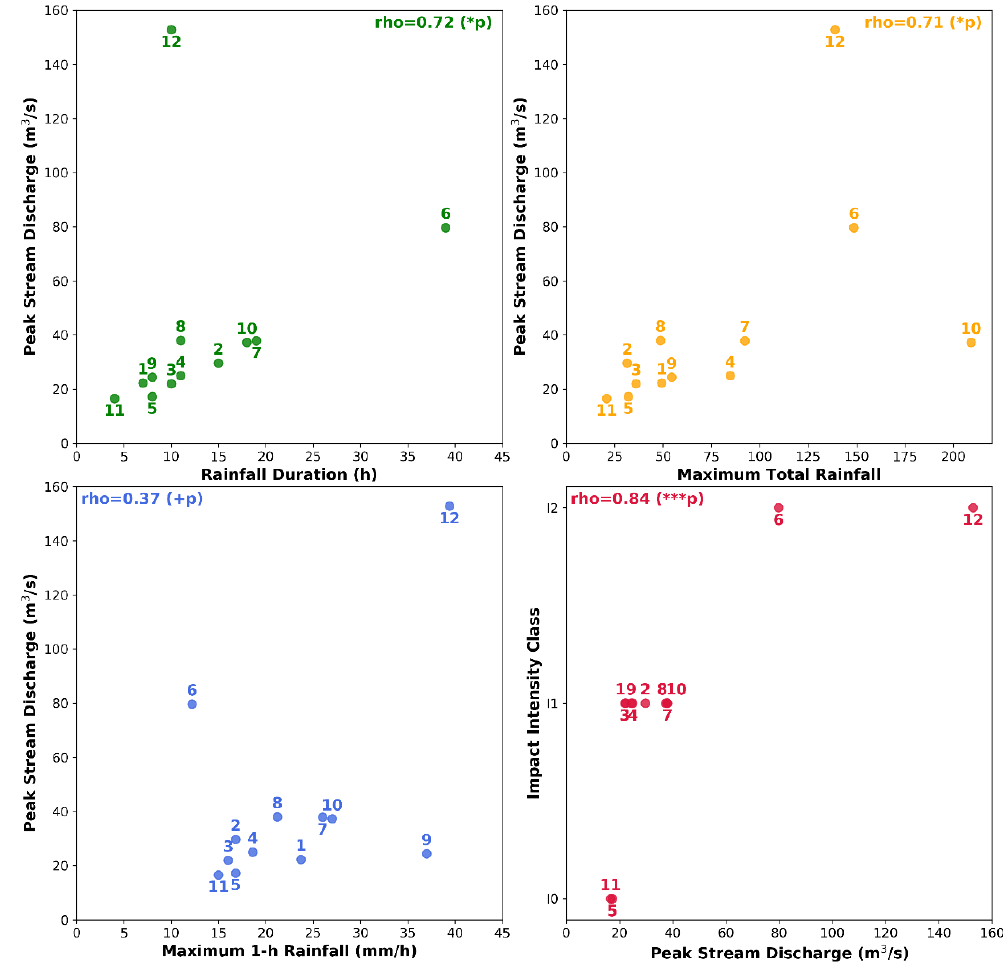
Figure 6. Maximum stream discharge against duration and maximum total and 1-h accumulations of precipitation, and impact intensity against maximum stream discharge. The numbers indicate the events IDs (Table 3), while rho values indicate the Spearman correlation coefficient, with statistical significance, p value, being symbolized as: + p (>0.05; not significant), * p (≤0.05; 95% confidence interval), ** p (<0.01; 99%confidence interval) and *** p (<0.001; 99.9% confidence interval).